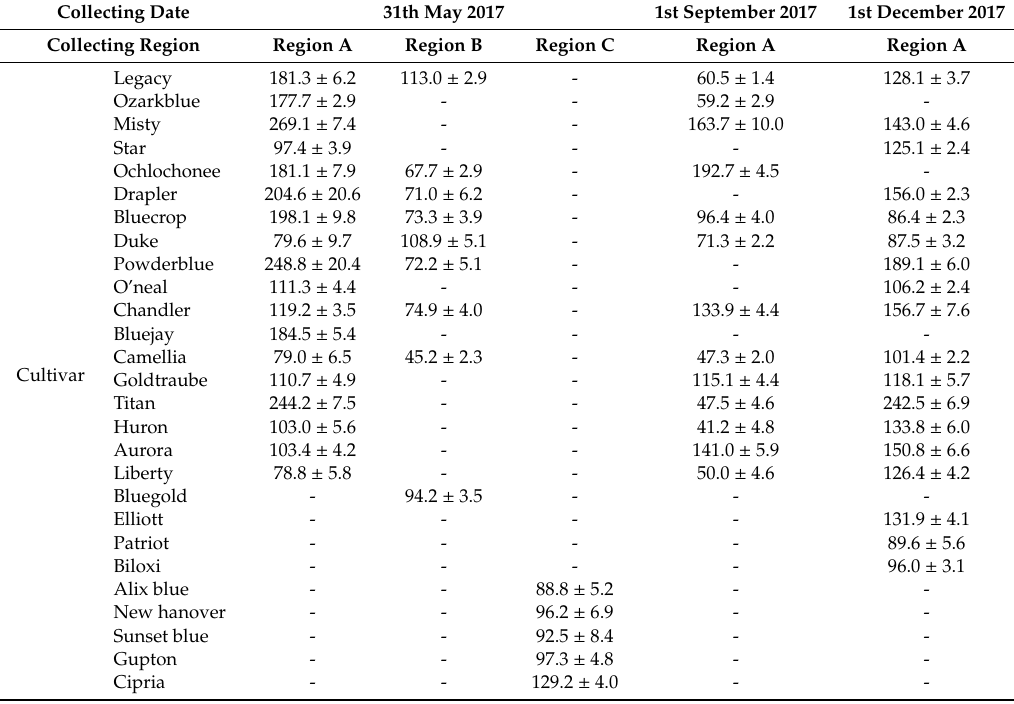
Table 2. Total flavonoid content (TFC), expressed in mg catechin / g dry leaf, obtained for all the cultivar leaves extracts harvested in three geographic regions and three seasons across the vegetative stage.